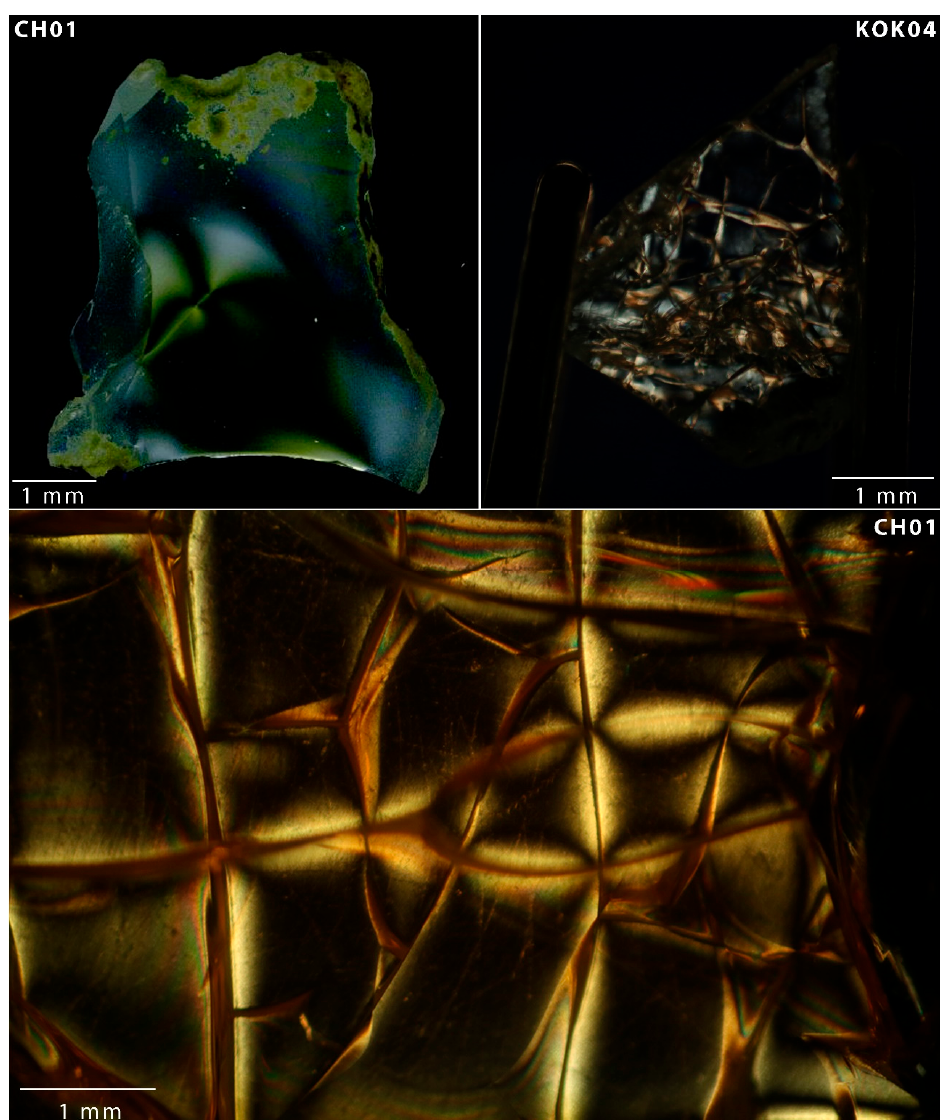
Figure 4. Microphotographs of samples of the two pieces of CH01 and one piece of KOK04 under cross-polarized light, with visible anisotropy around fractures.